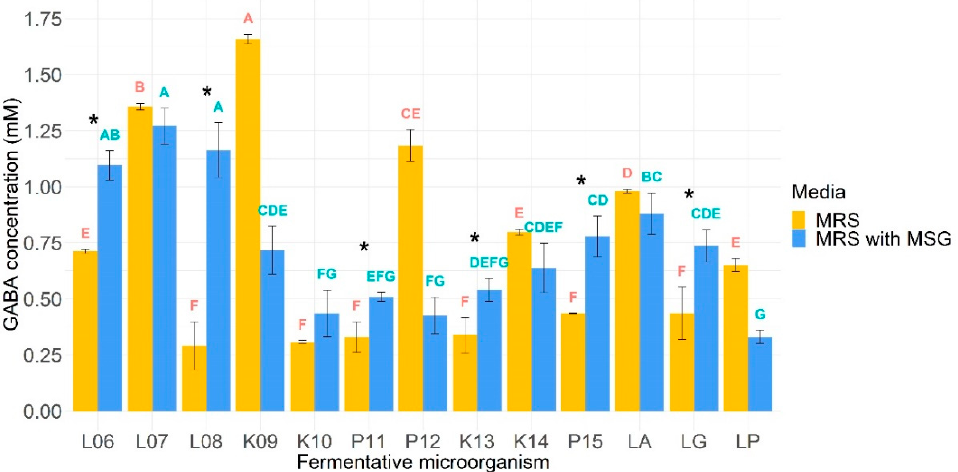
Figure 2. GABA-producing capacity of microorganisms in MRS and MRS supplemented with MSG. Means in the same incubation media that do not share a letter are significantly different. Fermentative microorganisms whose production of GABA increased significantly when incubated with MSG (respect to MRS-with MSG) were denoted with an asterisk. L06, L. lactis BIOTEC006; L07, L. lactis